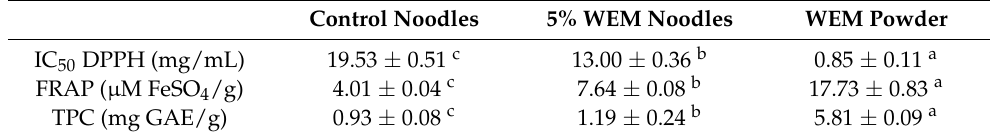
Table 5. The antioxidant activities and TPC of wood ear mushroom (WEM) powder and noodles incorporated with WEM and without WEM